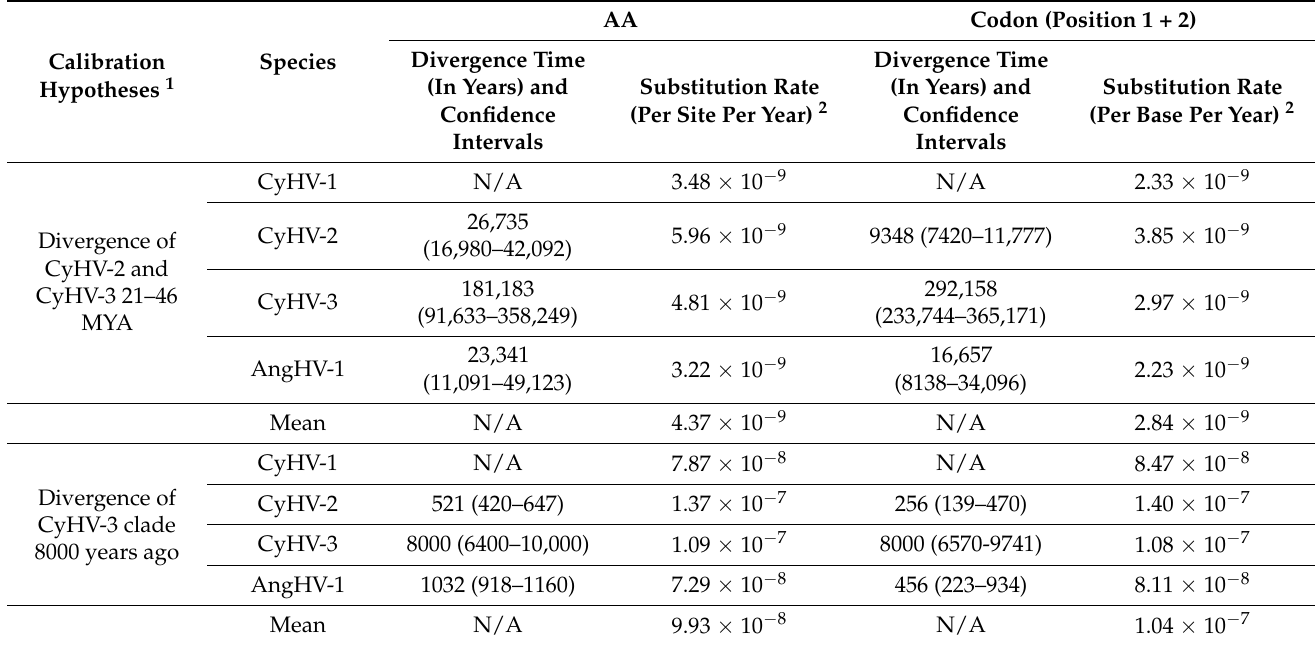
Table 4. Summary of species clade divergence time estimates and species-specific substitution rates generated as part of two different calibration hypotheses.